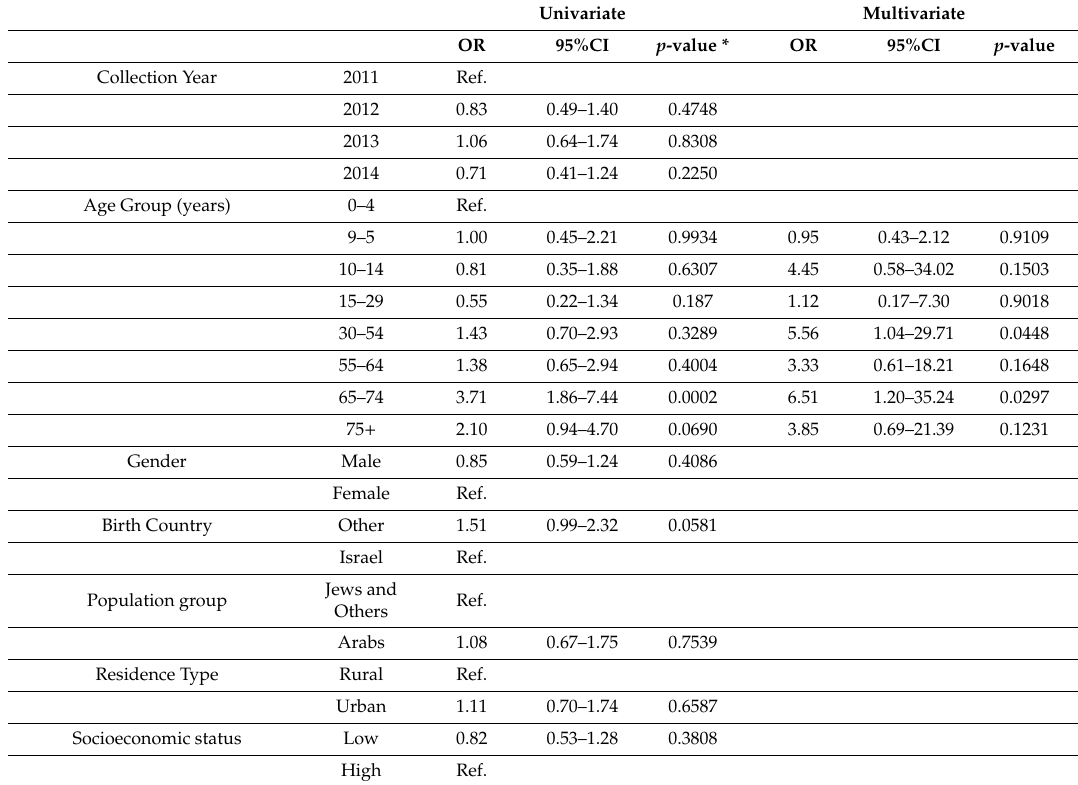
Table 2. Univariate and multivariate logistic regression analyses of demographic characteristics of individuals diagnosed with Sindbis virus by ELISA.